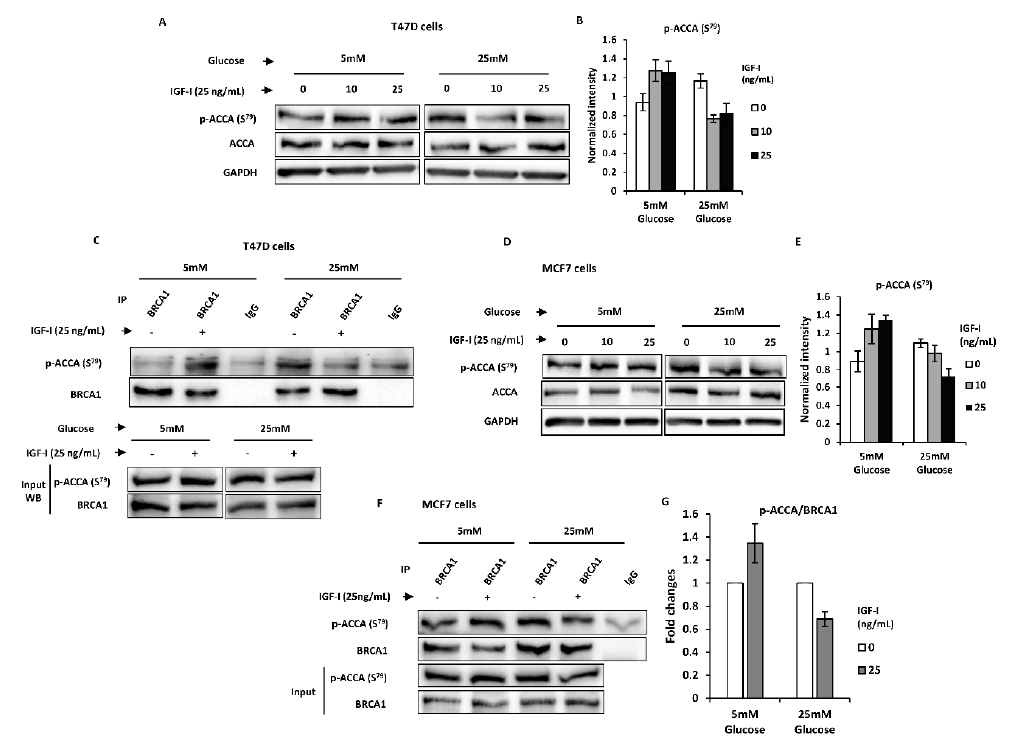
Figure 4. High glucose favours insulin ‐ like growth factor I (IGF ‐ I) ‐ induced lipogenic phenotype